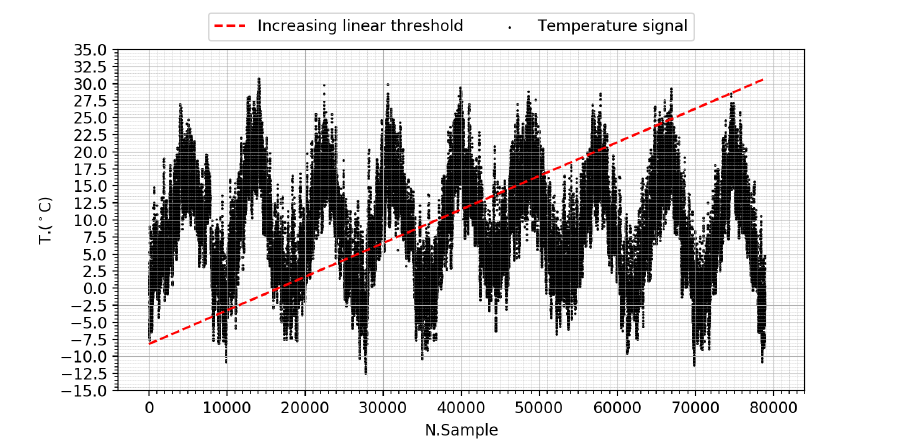
Figure 7. Representation of increasing linear threshold ‘K’, defined for the temperature signal extracted from the Oropa station.